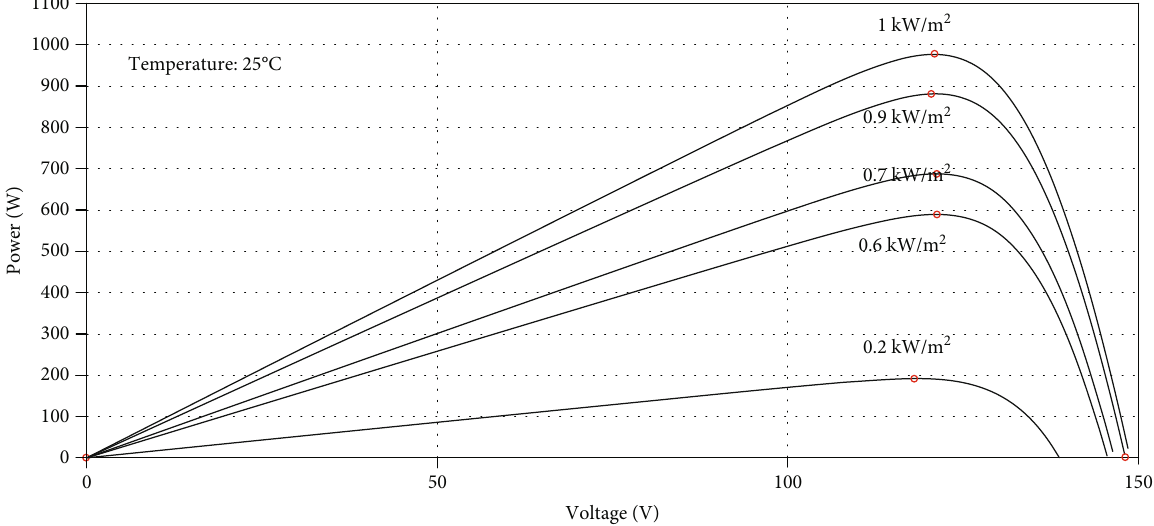
Figure 2: P-V curves of a PV array with di ff erent values of sun irradiance.